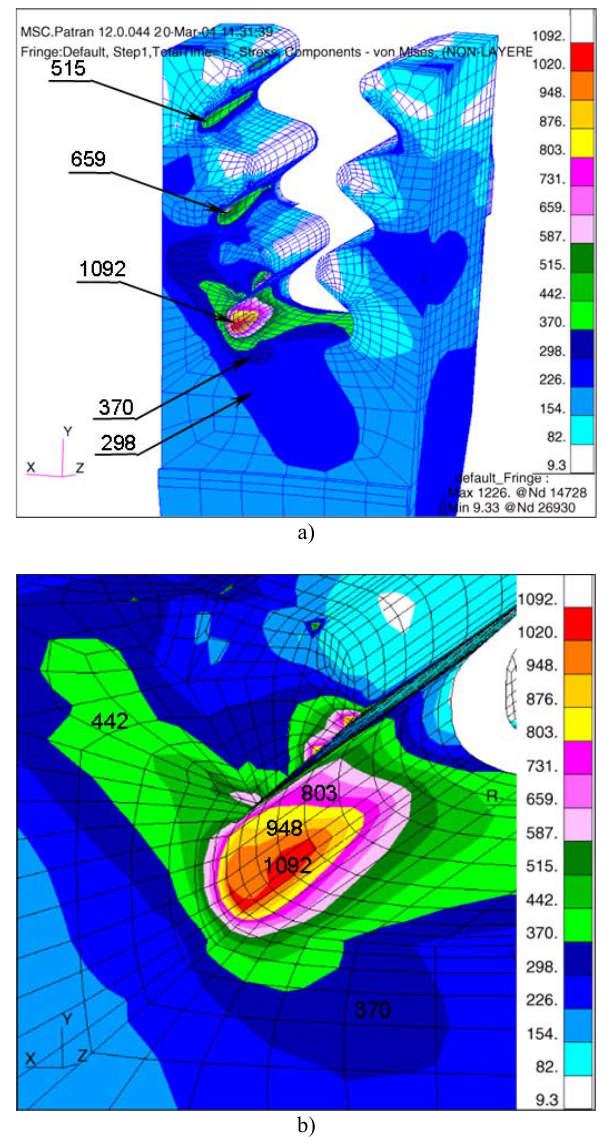
Fig 7 . Von Mises stress distribution in the vicinity of the serrated area of disc (a) and magnified view of maximum stress region (b)